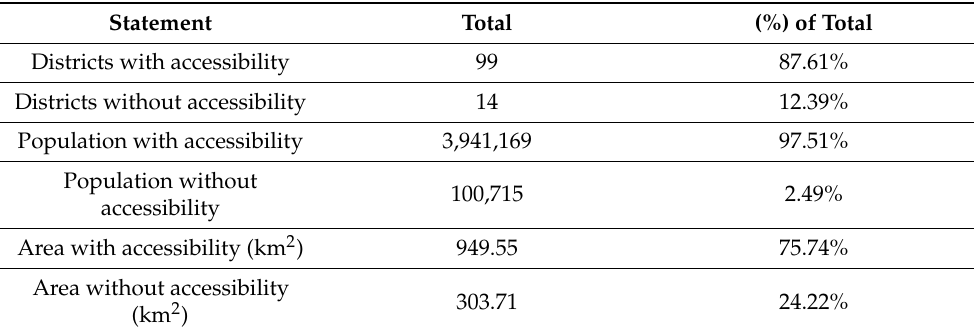
Table 2. Districts and population with spatial accessibility using